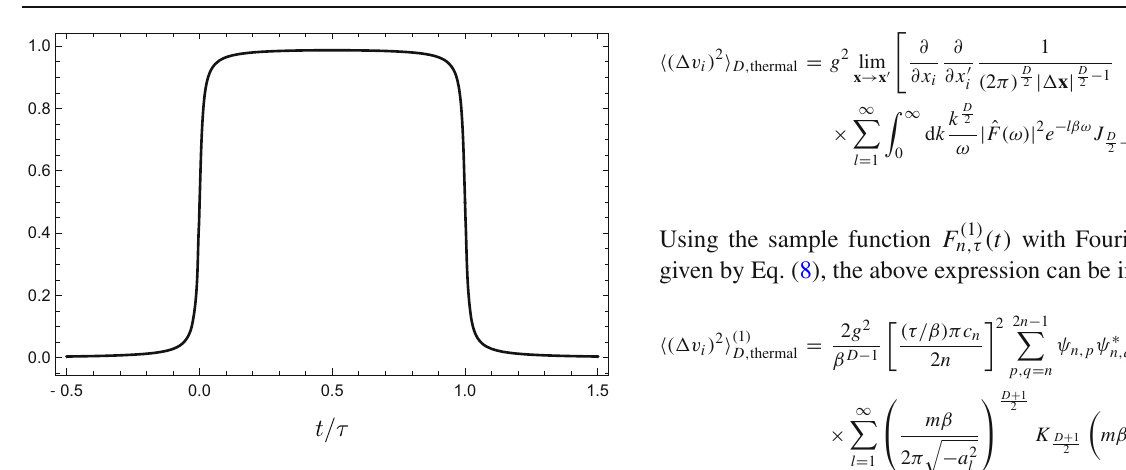
Fig. 1 Characteristic profile of the switching functions. Here, we plot- ( 2 ) ted F τ s ,τ ( t /τ) for τ s /τ = 0 .